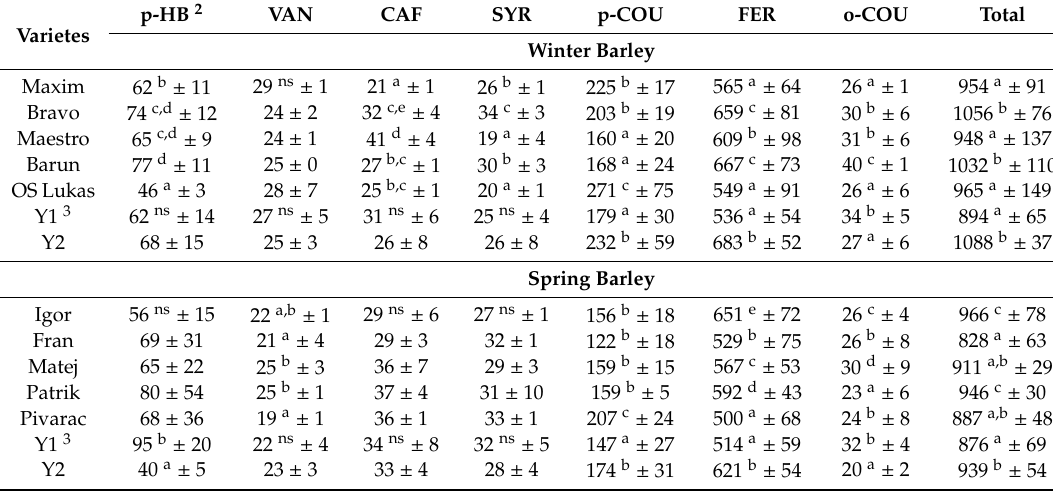
Table 4. Content 1 ( µ g / g dm ) of bound phenolic acids in winter and spring barley grains. p-HB 2 Varietes